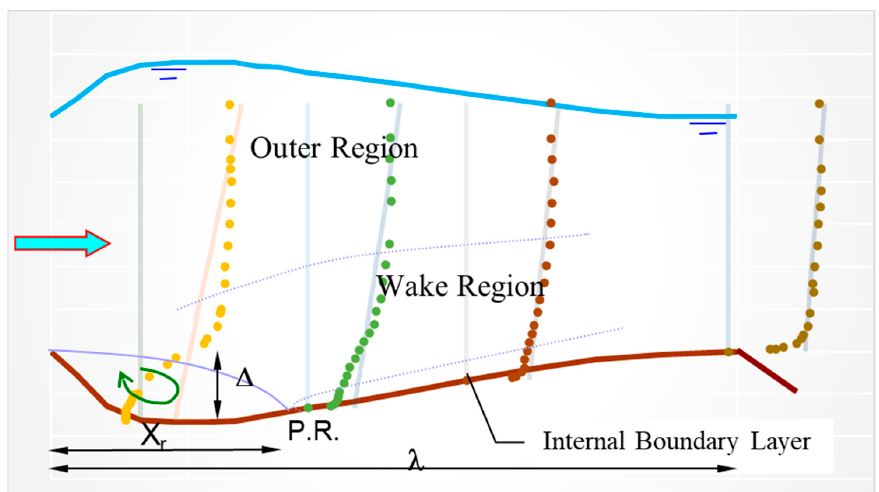
Figure 5. Flow structure over a bedform.